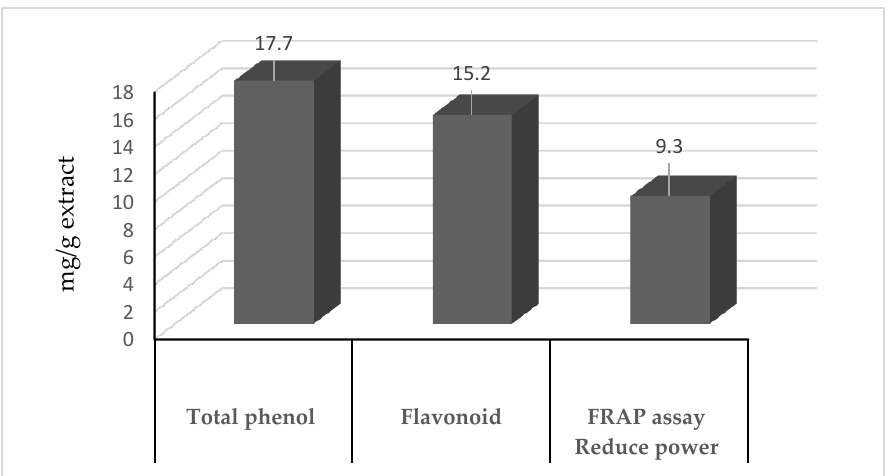
Figure 1. Analysis of total phenolic content, total flavonoid content, and their antioxidant capacity of the C. ternatea extract.